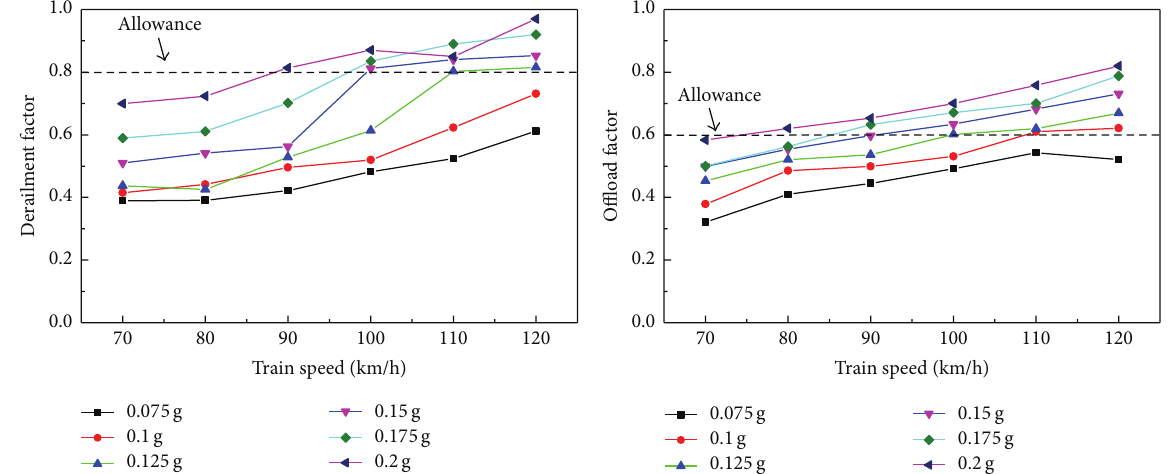
Figure 18: Running safety indices versus train speed during an earthquake.